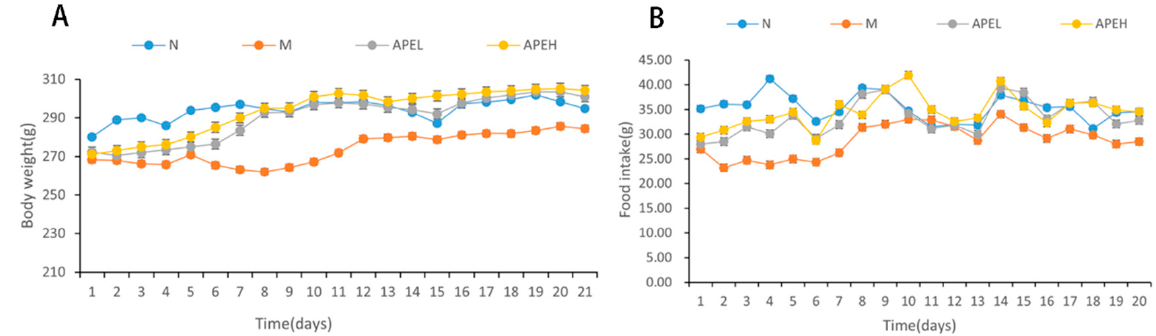
Figure 1. The body weight ( A ) and food intake ( B ) changes of mice in the process of APE admin- istration. (N, normal group; M, model group; APEL, 150 mg/kg APE group; APEH, 300 mg/kg APE group)